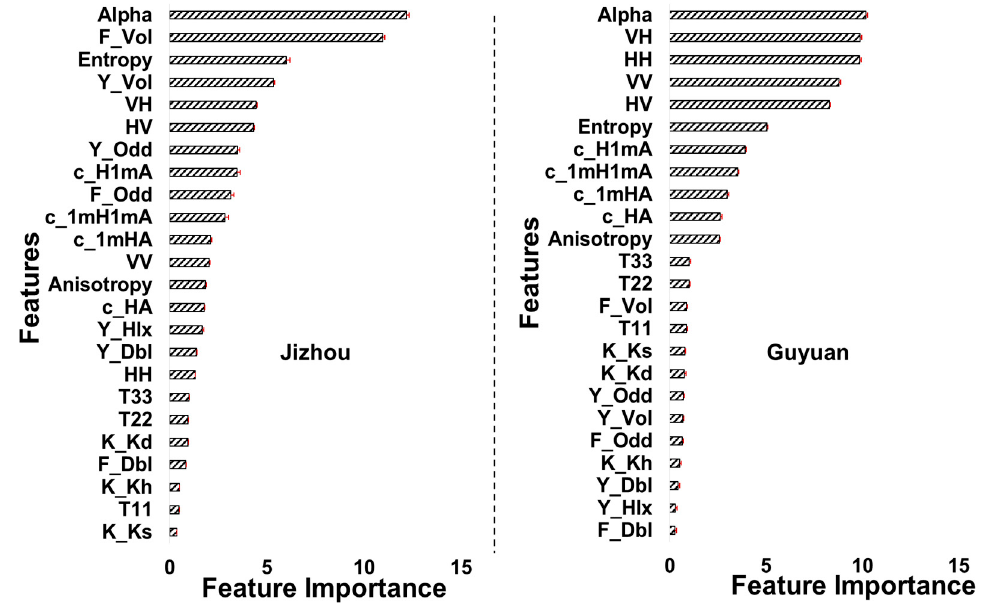
Figure 6. Bar graph (including the standard deviation) showing the SAR features’ importance assessed by RF for mapping PMF in Jizhou and Guyuan.